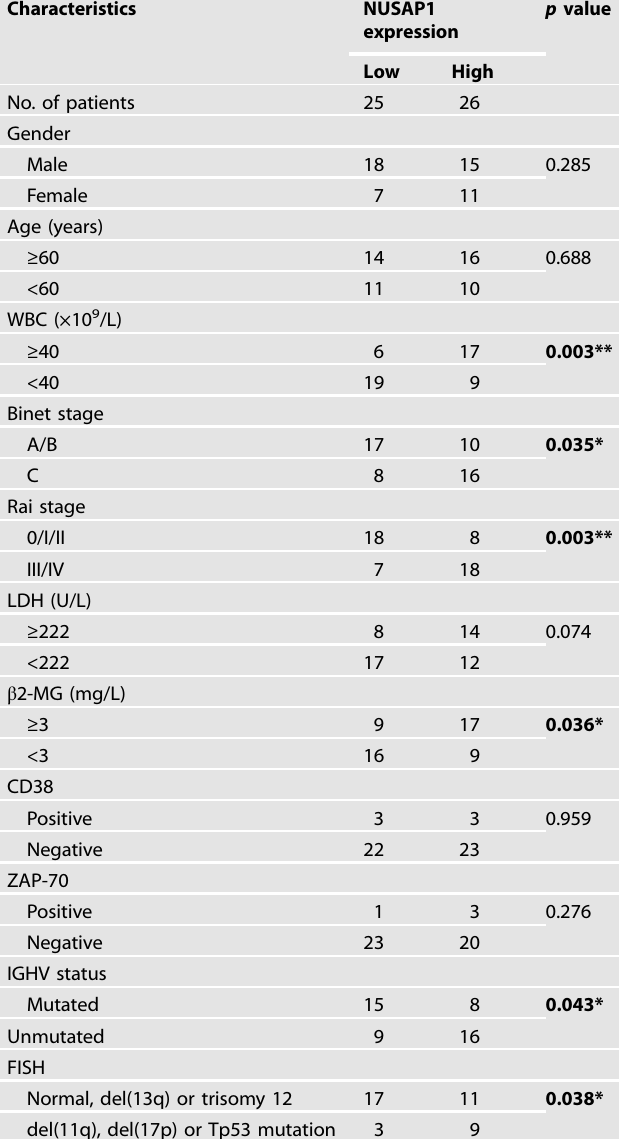
Table 1. Correlation between NUSAP1 expression and characteristics of CLL patients ( n =